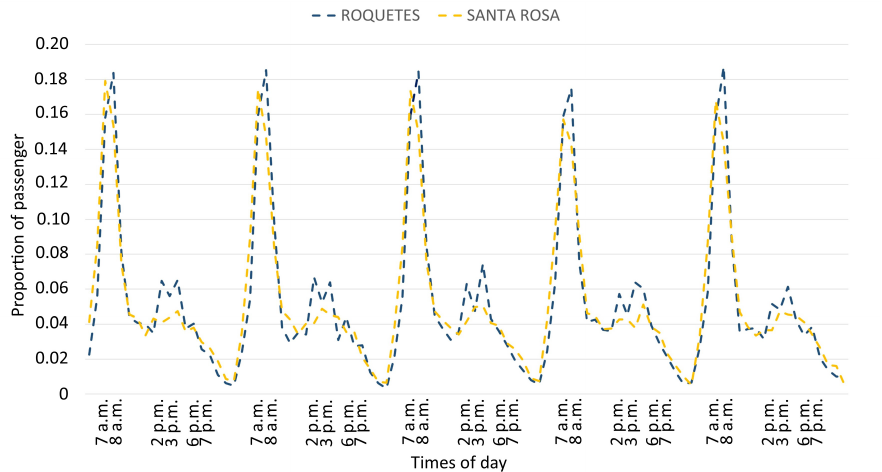
Figure 12. Pattern of boarding in stations in cluster 2 with morning rush hour on